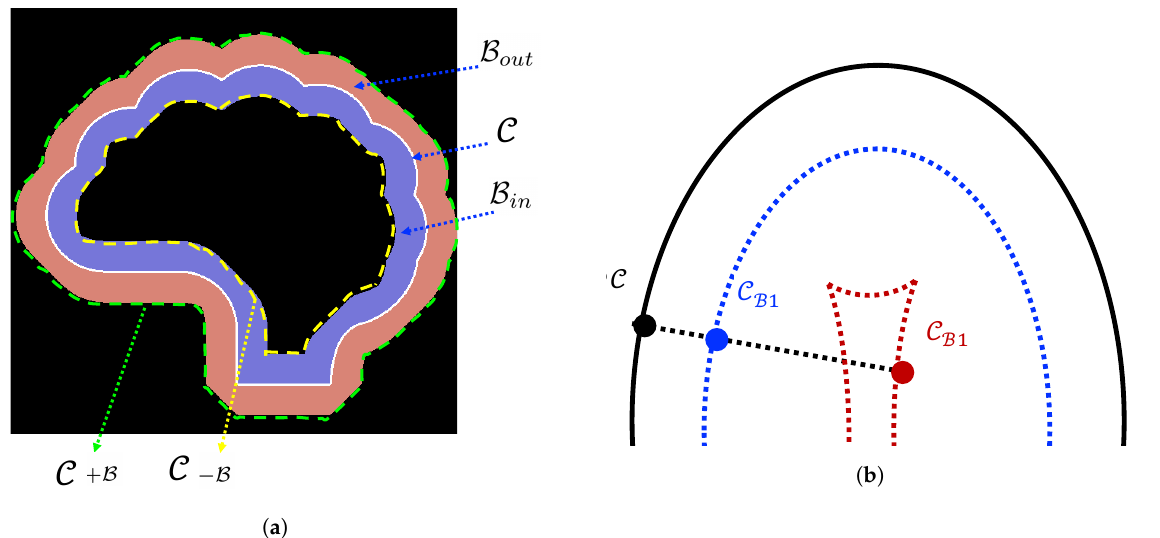
Figure 7. Demonstration of the offset curve theory, ( a ): illustration of the inner band B in and the outer band B out of a contour( C ) bounded by parallel curves C −B and C + B , ( b ): main curve C (black) and two parallel curves: blue curve C B 1 is generated by a small bandwidth of translation; red curve C B 2 is generated by a larger bandwidth of